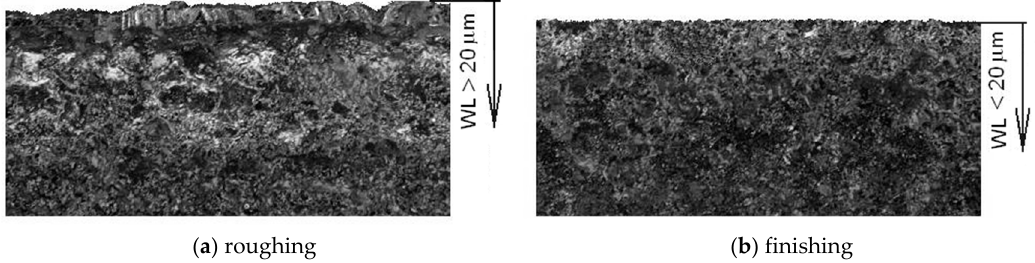
Figure 5. Total thickness of white layer (WL) in HAZ of steel EN X32CrMoV12 ‐ 28 after die ‐ sinking EDM roughing and finishing with SF ‐ Cu electrode, recorded by electron microscope with 1000× magnification.